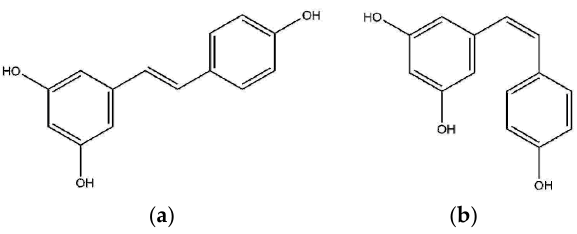
Figure 1. Structure of ( a ) trans -resveratrol (3,5,4 ′ -trihydroxystilbene) and ( b ) cis -resveratrol.